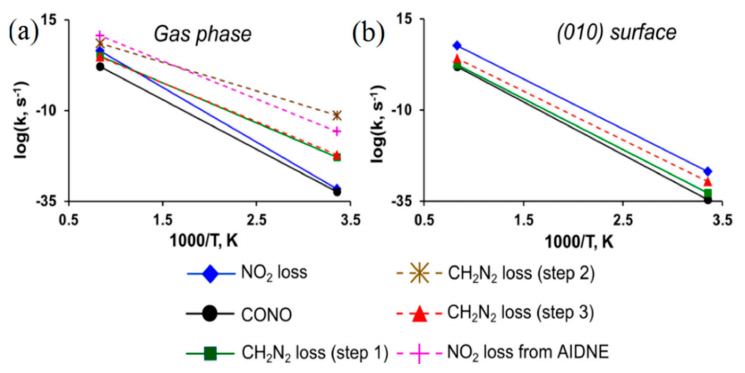
Figure 10. Reaction rates of DADNE decomposition ( a ) in the gas phase and ( b ) on the (010)